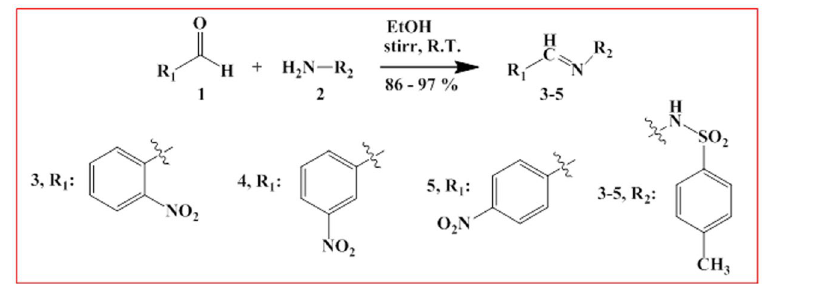
Figure 2. Synthesis of MNBBSH compounds condensation